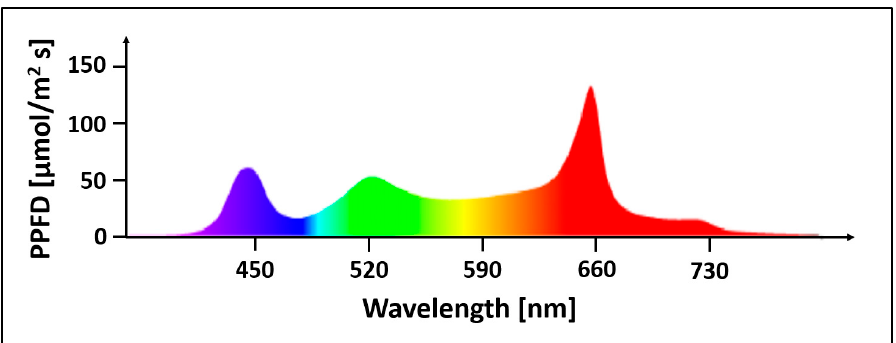
Figure 1. Graph of the light recipe used during growth tests for lettuce vegetative growth. The ver- tical axis displays the photosynthetic photon flux density (PPFD). vertical axis displays the photosynthetic photon flux density